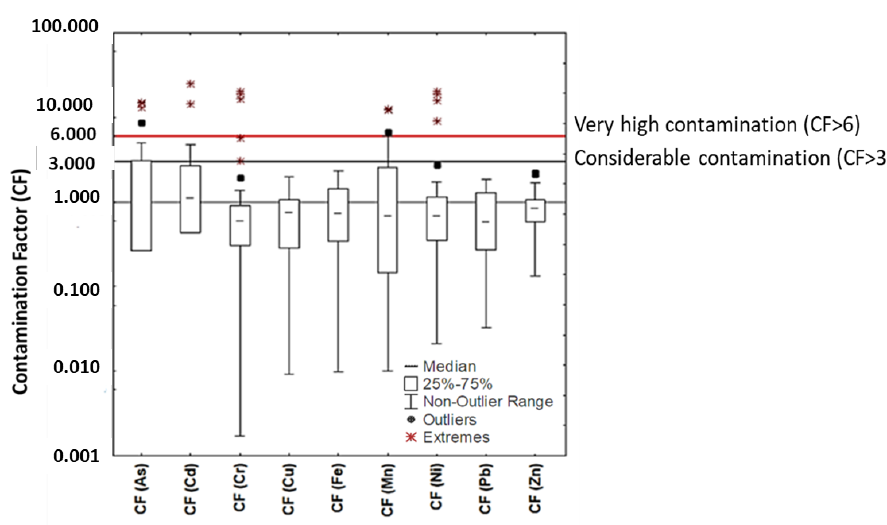
Figure 7. Box plot of Contamination Factor values for metals analyzed in the Conceição River ba- sin.